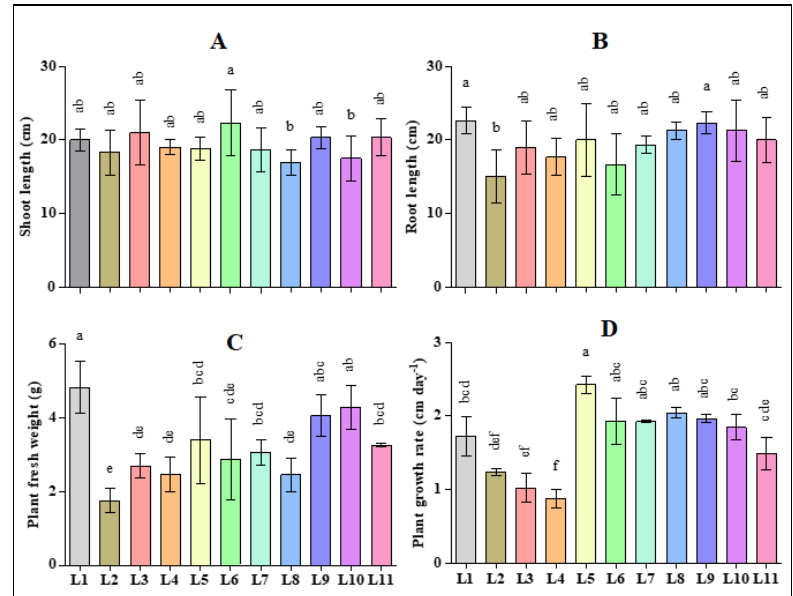
Figure 2. Effect of 20 days exposure to different LED spectra on the shoot length ( A ), root length ( B ), plant fresh weight ( C ), and plant growth rate ( D ) of hemp seedlings. Here and subsequent figures: L1, Natural light; L2, White; L3, R 8 :B 2 ; L4, R 7 :B 2 :G 1 ; L5, R 7 :B 2 :FR 1 ; L6, R 6 :B 2 :G 1 :FR 1 ; L7, R 5 :B 2 :W 2 :FR 1 ; L8, R 5 :B 2 :G 1 :FR 1 :UV 1 ; L9, R 6 :B 2 :FR 1 :UV 1 ; L10, R 4 :B 2 :W 2 :FR 1 :UV 1 ; L11, R 2 :B 2 :G 2 :W 2 :FR 1 :UV 1 . All treatments used a photosynthetic photon flux density of 300 µ mol m − 2 s − 1 . Column height indicates the mean, vertical bars indicate the standard error of the mean (n = 4), and different letters indicate significant differences at p < 0.05.